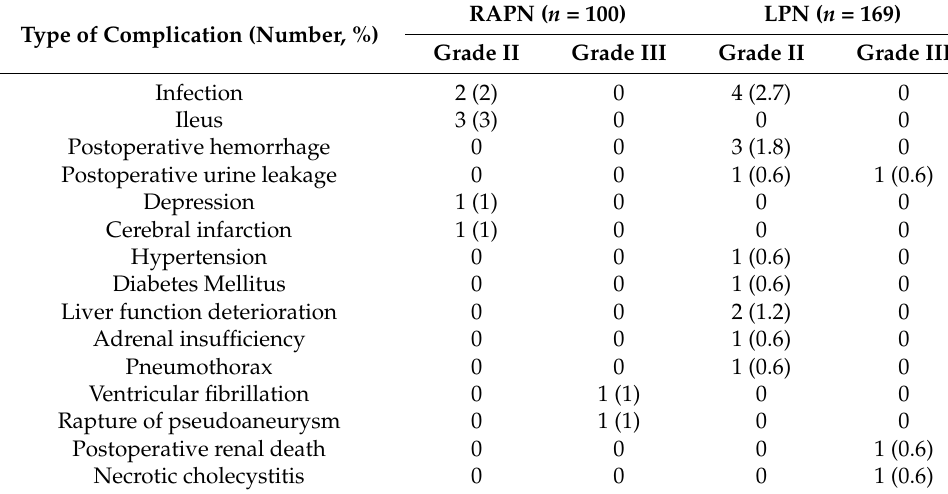
Table 5. Perioperative complications.